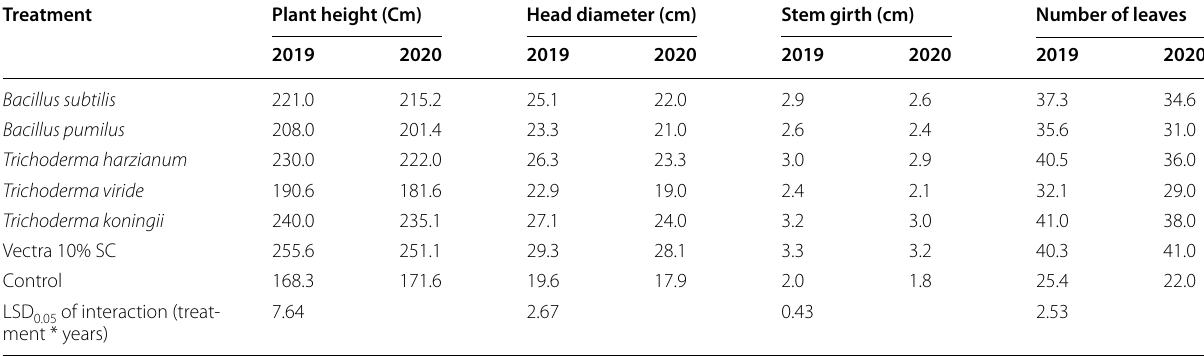
Table 4 Effects of certain treatments on growth parameters of sunflower plants against powdery mildew disease during 2019 and 2020 seasons Treatment Plant height (Cm) Head diameter (cm) Stem girth (cm) Number of